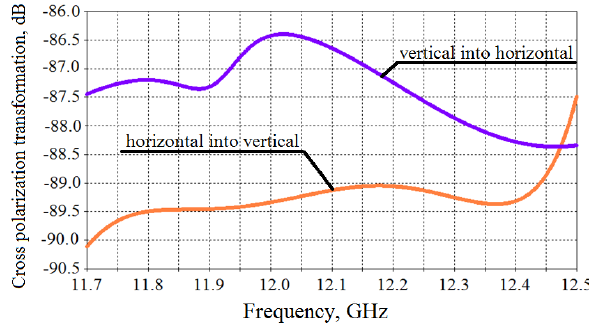
FIGURE 10. Dependences of module of cross polarization transformation coefficients on frequency for both polarizations calculated by numerical model.